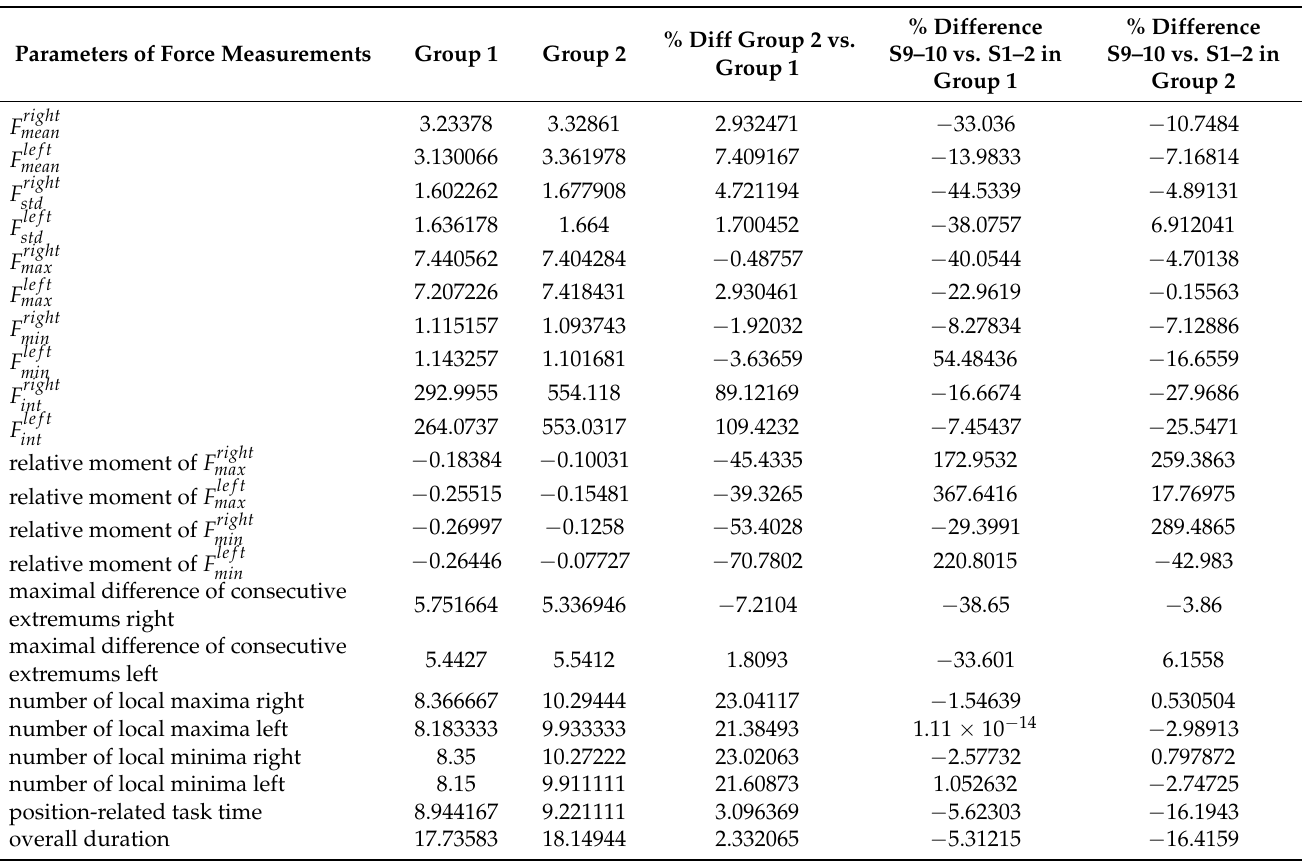
Table 2. Analysis of